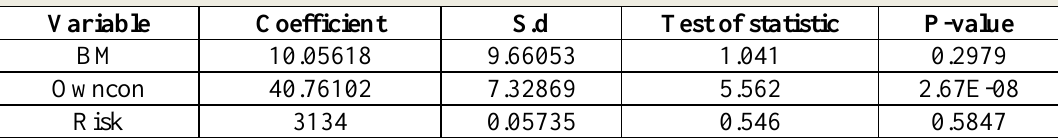
Table 4. The results of model fitting for evaluating the relationship between the percentage of unbounded members, ownership concentration, and risk and the value creation of a